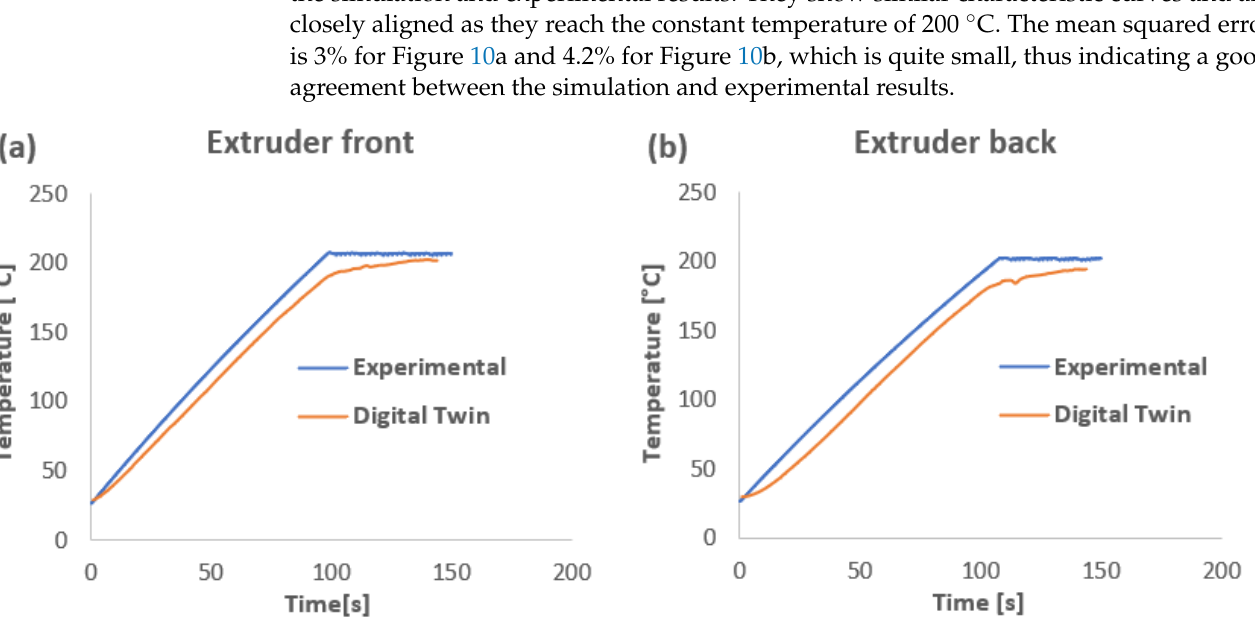
Figure 10. Comparison between experimental and digital twin simulation results: ( a ) Extruder front profile; ( b ) Extruder back profile.